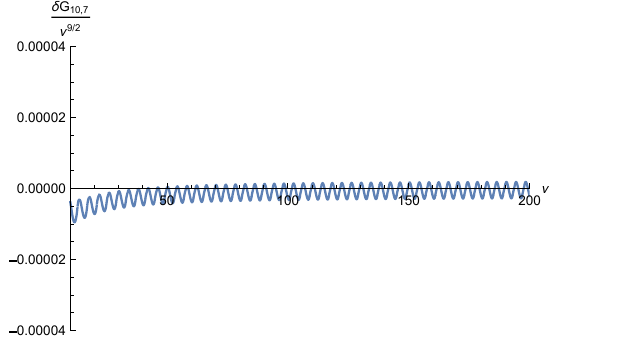
Figure 8 . Subleading tail in G J =2 versus (cid:23) .